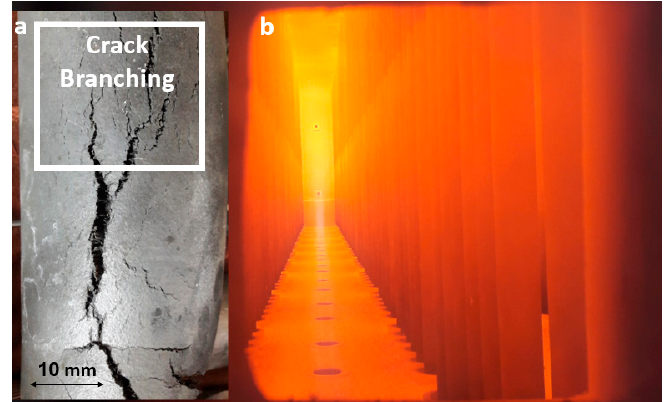
Figure 1. ( a ) Example of failed tubes and ( b ) an image of tubes in service.